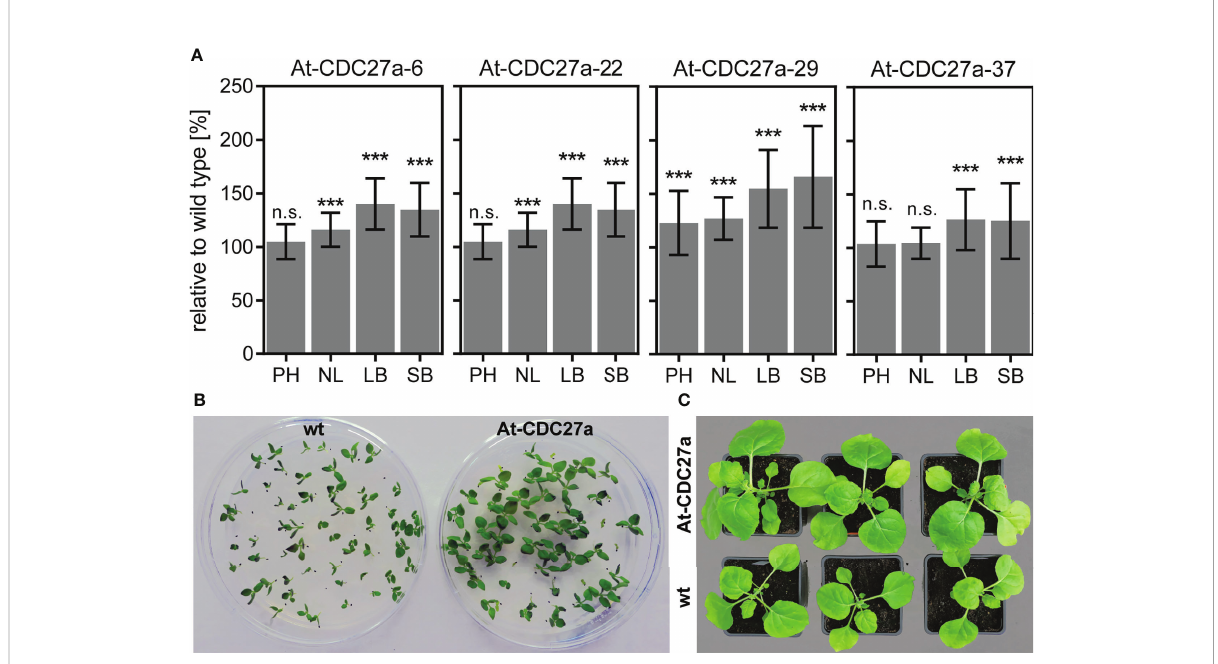
FIGURE 2 Phenotype of the At-CDC27a transgenic lines. (A) Assessment of plant height (PH), number of leaves (NL), leaf biomass (LB) and stem biomass (SB). The measurements were performed on the non-transgenic and T1 progeny of the At-CDC27a-6, At-CDC27a-22, At-CDC27a-29 and At- CDC27a-37 transgenic plants grown in the greenhouse for 4 weeks. The plant height, number of leaves and above ground biomass characteristics are expressed as a percent relative to the wild type. Values represent the means with standard deviation (n = 30). Asterisks indicate signi fi cance as determined by the unpaired T-test, with *** denoting p < 0.001. Not signi fi cant values are determined as ns. The At- CDC27a-29 and non-transgenic plants grown in vitro (B) and in soil (C) . The wild type N. benthamiana seeds and T1 progeny seeds of the At- CDC27a-29 line were germinated in vitro under nonselective and selective (5 mg/L PPT) conditions, respectively, and photographed at 12 days after sowing. The soil-grown plants were photographed at 21 days after